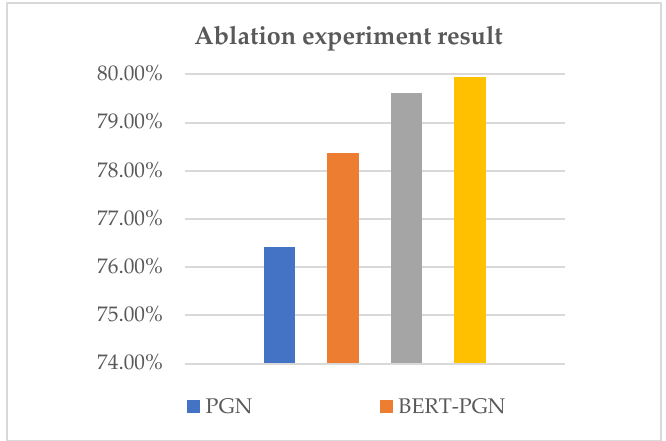
Figure 7. Comparison results with other models.